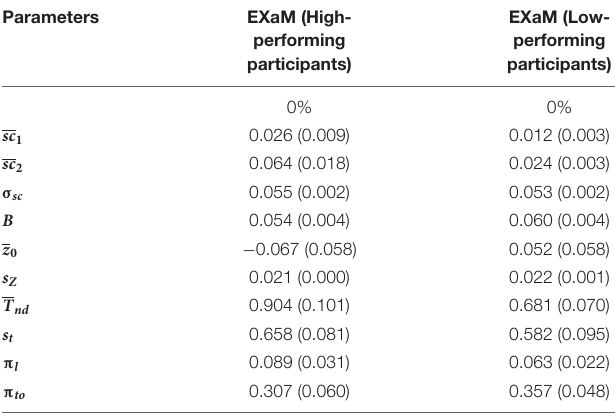
TABLE 2 | Mean of average posterior parameter distributions of EXaM for the high- and low-performing of participants. Parameters EXaM (High- performing